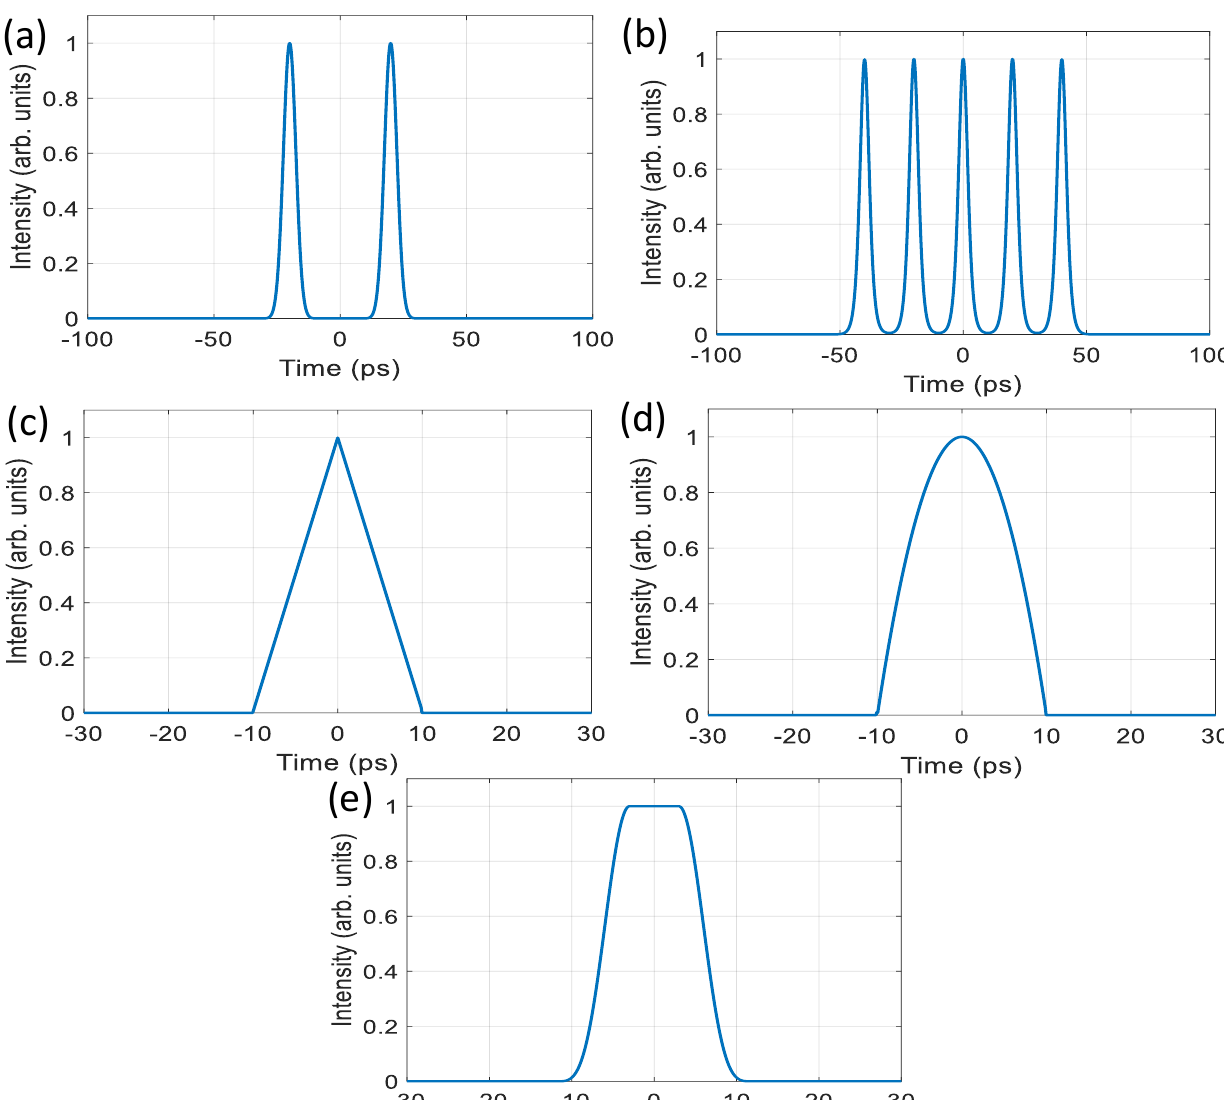
Figure 4. Target pulse intensity profiles: ( a ) Two equal amplitude chirp-free 3.5 ps transform-limited Gaussian pulses separated by 20 ps, ( b ) Five equal amplitude chirp-free 2 ps transform-limited Gaussian pulses separated by 20 ps (inter- pulse amplitude fluctuations < 15%), ( c ) One 20 ps chirp-free triangular pulse intensity profile, ( d ) One 20 ps chirp-free parabolic pulse intensity profile, ( e ) One 20 ps chirp-free raised-cosine pulse, with a 10 ps flat-top